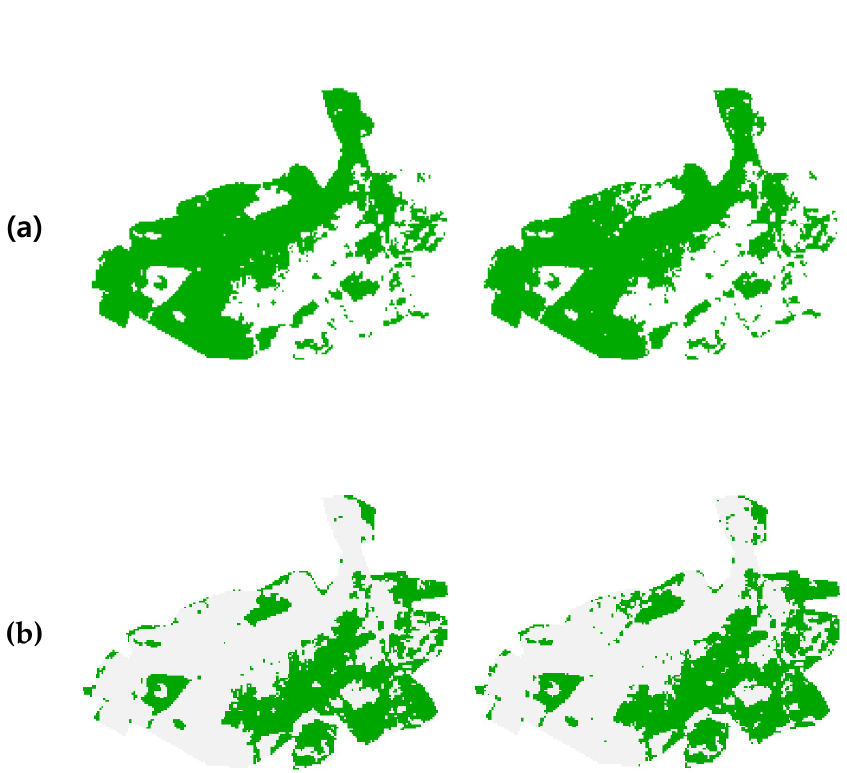
Figure 6. Vegetation classification image on Geomunoreum forest from 2020 to 2021. ( a ) Evergreen (NDVI values > 0.6); ( b ) deciduous (0.6 ≥ NDVI values). Table 1. The number of pixels and ratio of the evergreen and deciduous area on Geomunoreum for 2017 to 2021.